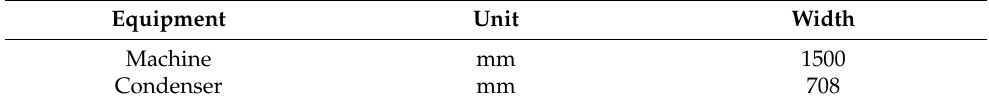
Table 6. Machine and condenser width.